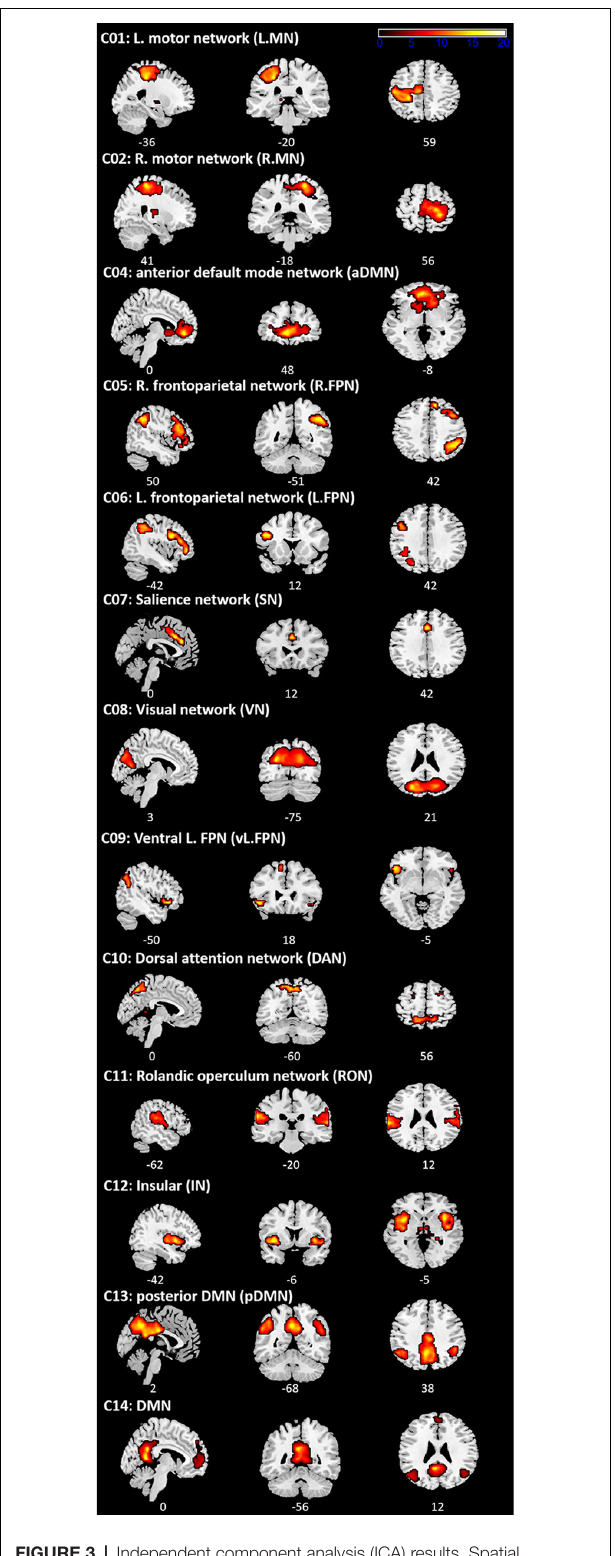
FIGURE 3 | Independent component analysis (ICA) results. Spatial distribution of 13 networks. See Supplementary Table S3 for the Montreal Neurological Institute (MNI)